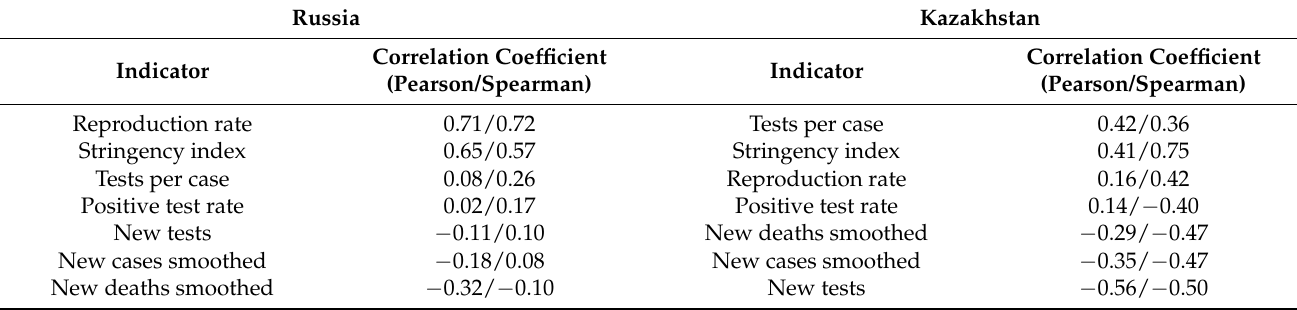
Table 6. Correlation between numbers of news stories with negative sentiment and COVID-19 indicators.